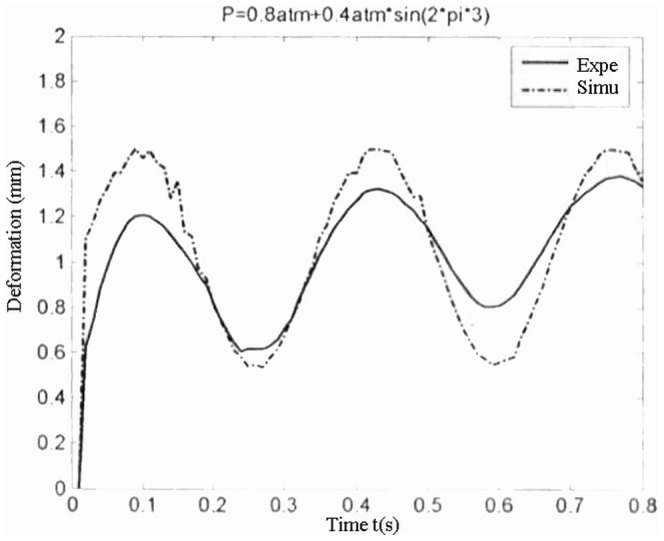
Finger deformation with 3